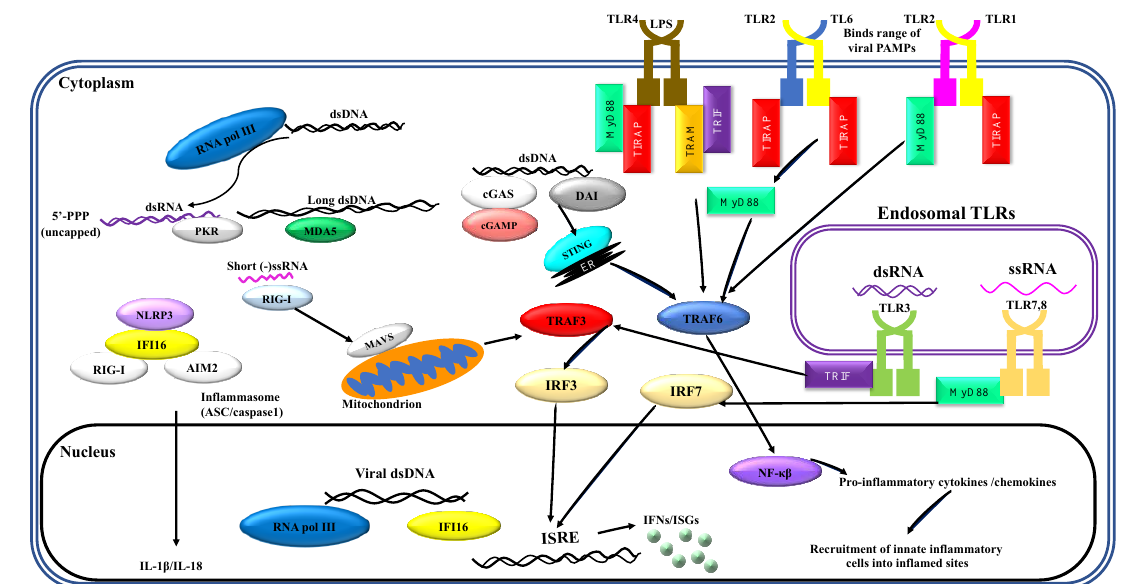
Figure 1. Virus-induced inflammatory responses. Recognition of viral pathogen-associated molecular patterns (PAMPs) by innate cells of the immune system results in inflammatory responses. Activation of innate leukocytes via pattern recognition receptors (PRRs) that recognize viral PAMPs in different cellular compartments gives rise to a number of intracellular signaling cascades, mediated by various interconnected adaptor proteins. This results in interferon regulatory factor (IRF)-mediated upregulation of interferons (IFNs) and interferon-stimulated genes (ISGs), as well as nuclear factor kappa-light-chain-enhancer of activated B cells (NF-κB)-mediated induction of inflammatory cytokines and chemokines. Furthermore, sensing of viral PAMPs by NOD-like receptor family pyrin domain containing 3 (NLRP3), retinoic acid-inducible gene I (RIG-I), absent in melanoma 2-like receptors (AIM2), and/or IFN-inducible protein 16 (IFI16) potentiates the formation of inflammasome complexes, which ultimately result in the induction of inflammatory cytokines such as interleukin (IL)-1β and IL-18. Other abbreviations: cGAMP: cyclic guanosine monophosphate–adenosine monophosphate, cGAS: cyclic guanosine monophosphate–adenosine monophosphate synthase, DAI: deoxyribonucleic acid (DNA)-dependent activator of interferon regulatory factors, ds: double-stranded, ER: endoplasmic reticulum, ISRE: interferon-sensitive response element, MAVS: mitochondrial antiviral signaling protein, MDA5: melanoma differentiation-associated protein 5, MyD88: myeloid differentiation primary response 88, NOD: nucleotide-binding oligomerization domain, PKR: protein kinase R, pol: polymerase, RNA: ribonucleic acid, ss: single-stranded, STING: stimulator of interferon genes, TIRAP: Toll/interleukin-1 receptor (TIR) domain-containing adapter protein, TLR: toll-like receptor, TRAF: tumor necrosis factor receptor–associated factor, TRAM: TIR-domain-containing adapter-inducing IFN-β (TRIF)-related adaptor molecule.